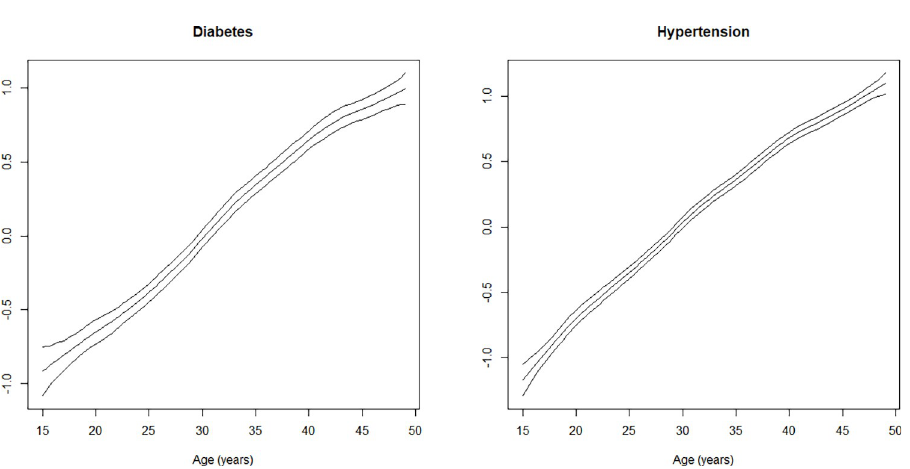
Fig 4. Non-linear effects of age on the log-odds of diabetes and hypertension (posterior means along with the 97.5% credible interval are shown).